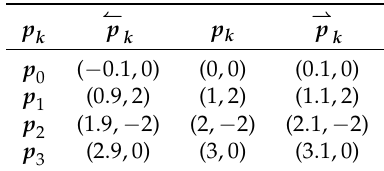
Table 2. Fuzzy control